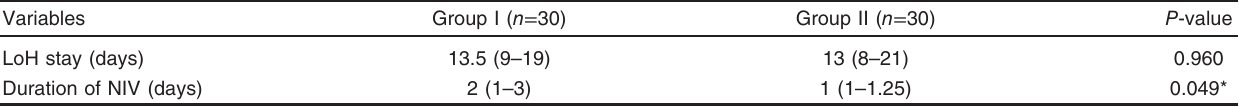
Table 7 Effect of BiPAP therapy on length of hospital stay and duration of noninvasive ventilation on both groups ( n = 60)